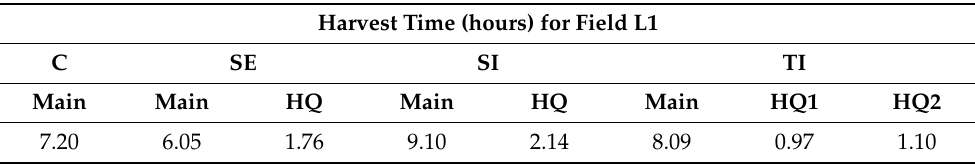
Table 2. Detailed estimated harvest times in hours of field L1 for the four harvesting cases and their field divisions.